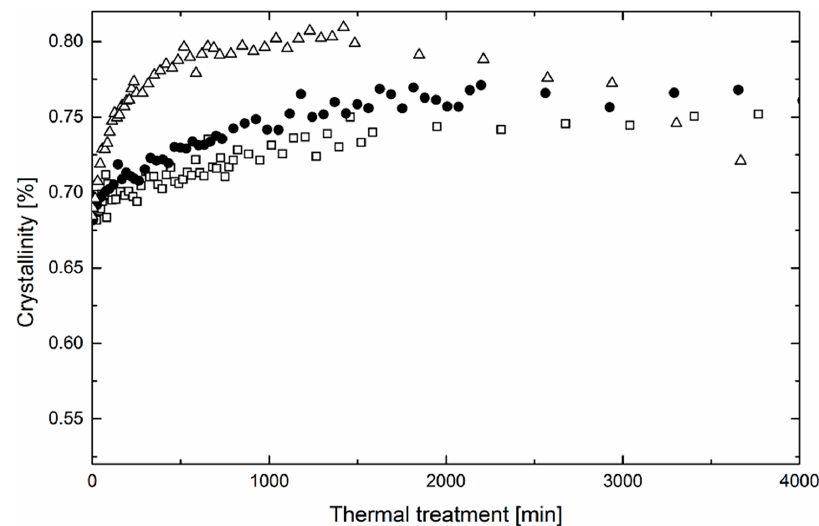
Figure 6. Evolution of crystalline structure of nanofibrous webs prepared from methanol / PEO solution at three different temperatures in time (squares denote 40 °C, circles 50 °C, and triangles 60 °C).